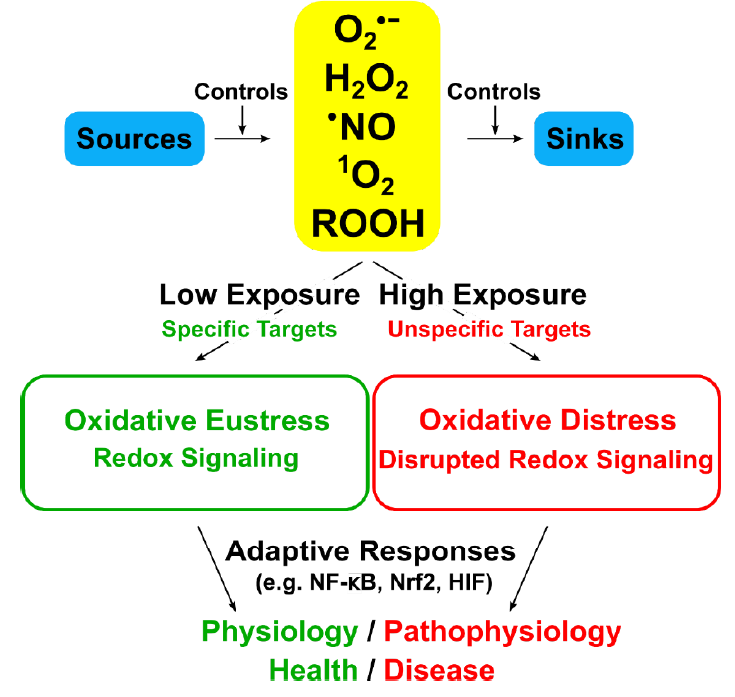
Figure 1. Oxidative stress and its relationship to redox signaling . Physiological (low) oxidant exposure addresses specific (highly-reactive) targets, whereas supraphysiological (high) exposure addresses unspecific targets. Adaptive responses counteract. Further important oxidants are generated in secondary reactions; e.g., ONOOH, from O 2 ·− and · NO, or HOCl, from H 2 O 2 and Cl − . Modified from Ref. [6]. Creative Commons License.